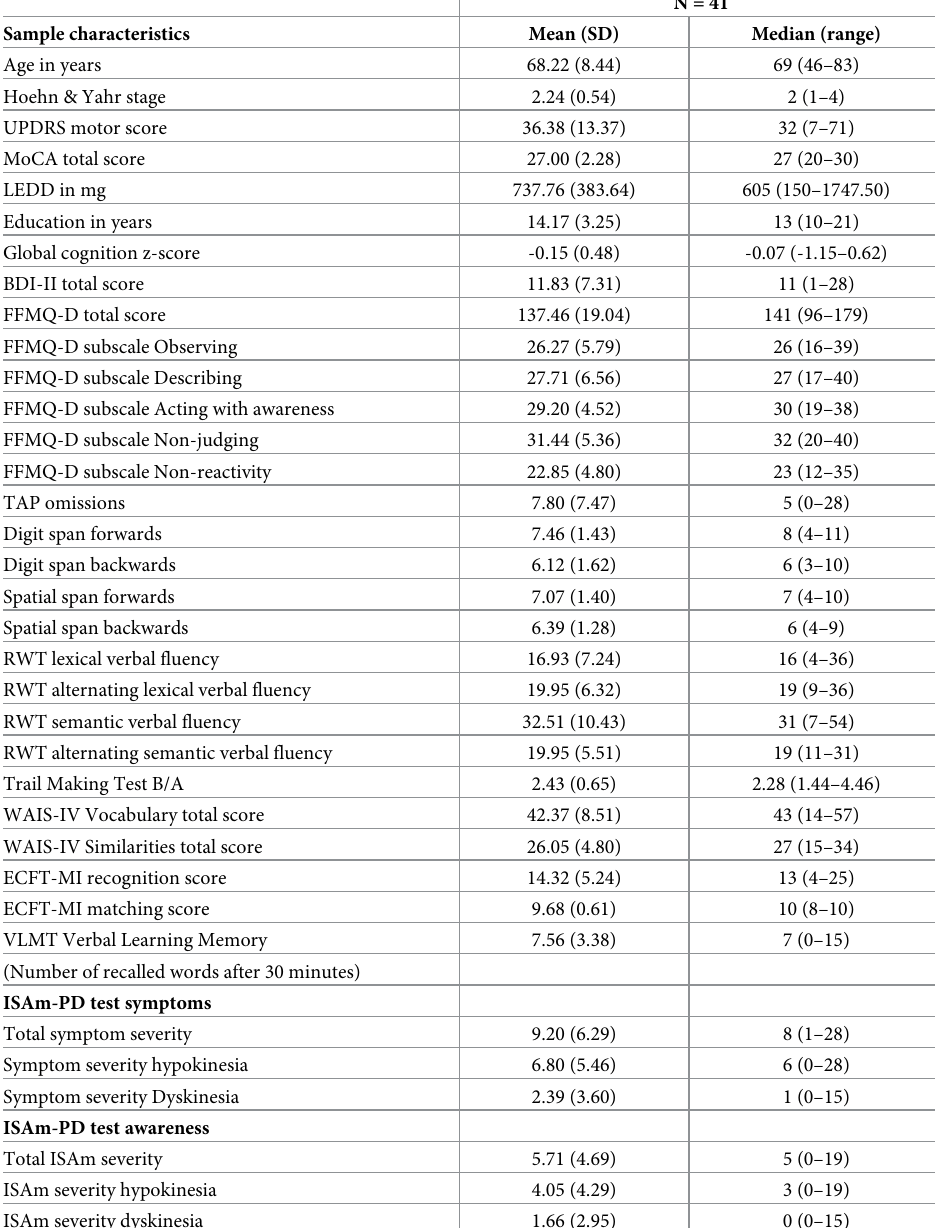
Table 2. Sample characteristics of all PD